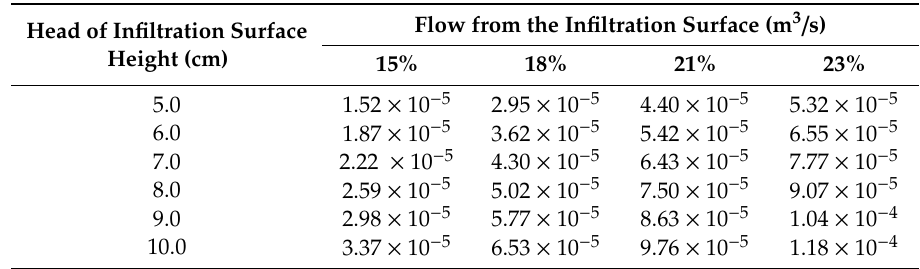
Table 2. Three-dimensional finite element calculation results of infiltration flow corresponding to di ff erent infiltration surface head heights.